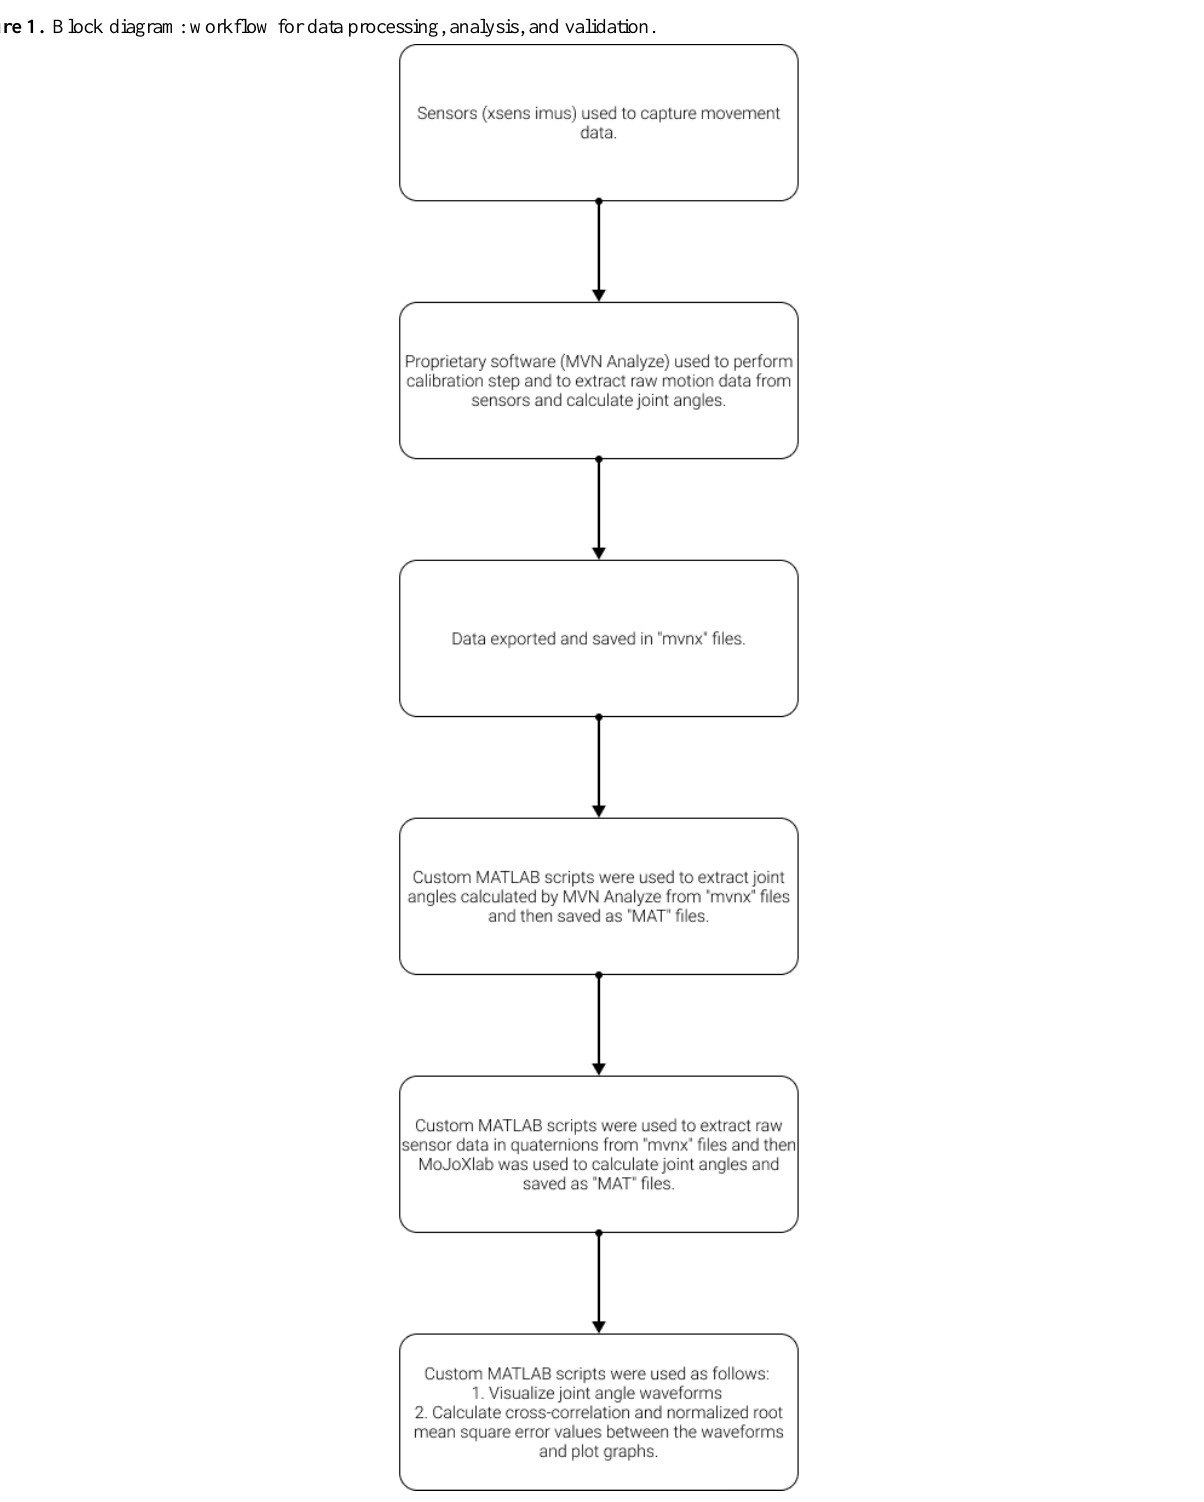
Figure 1. Block diagram: workflow for data processing, analysis, and